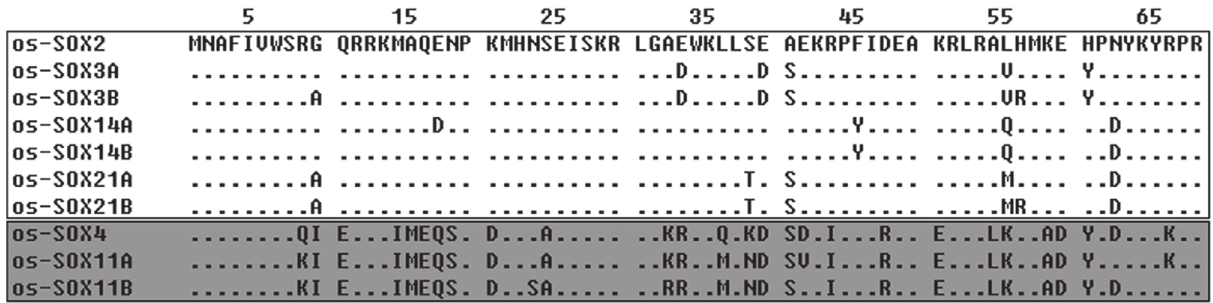
Figure 2. Alignment of the putative amino acid sequence of the HMG domain of os-SOX proteins. ( (cid:2) ) SOXB subgroup, ( (cid:3) ) SOXC subgroup. Amino acid residues identical to os-SOX2 are indicated by a dash.